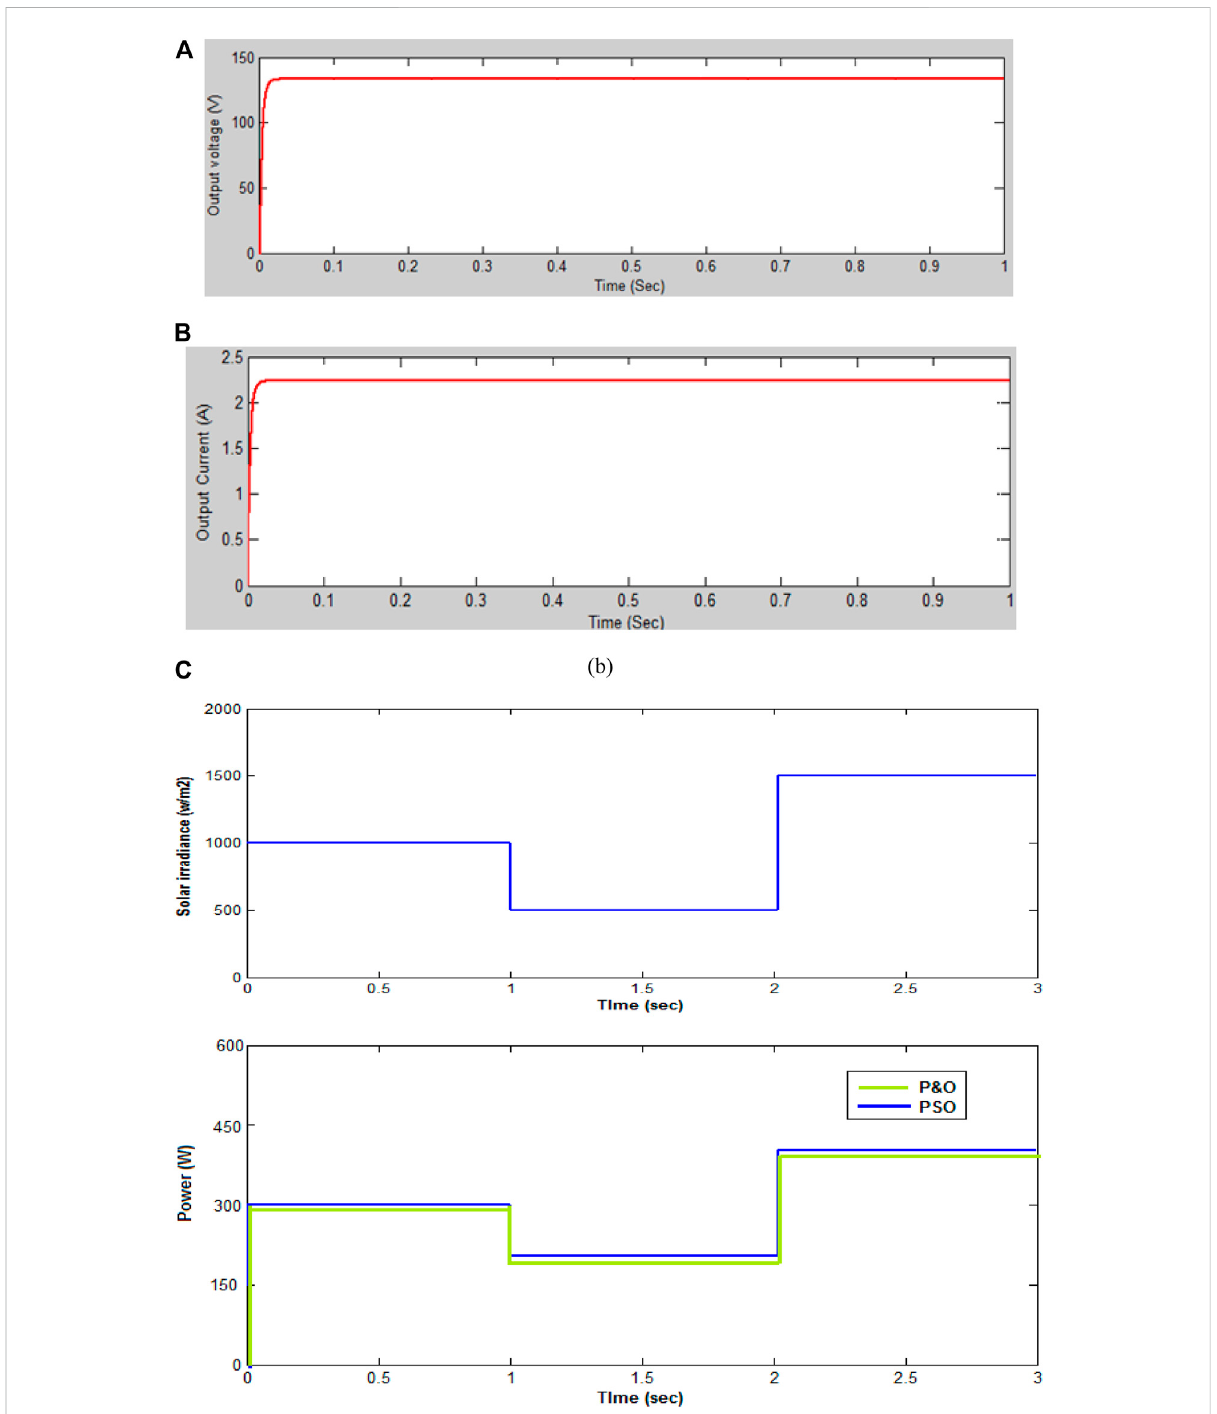
FIGURE 8 (A) The output voltage of the dual input single output non-isolated converter fed by solar PV. (B) The output current of the dual input single output non-isolated converter fed by solar PV (C) . The maximum power extracted from a solar PV using a PSO and a conventional P&O